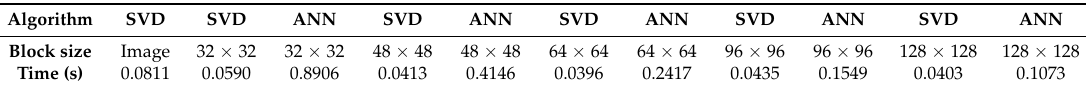
Table 3. The average computational times for the block-based noise level estimation